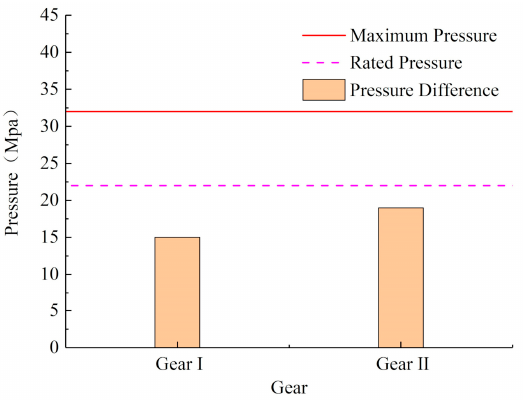
Figure 9. Analysis of the pressure difference between the inlet and outlet of the hydraulic motor.